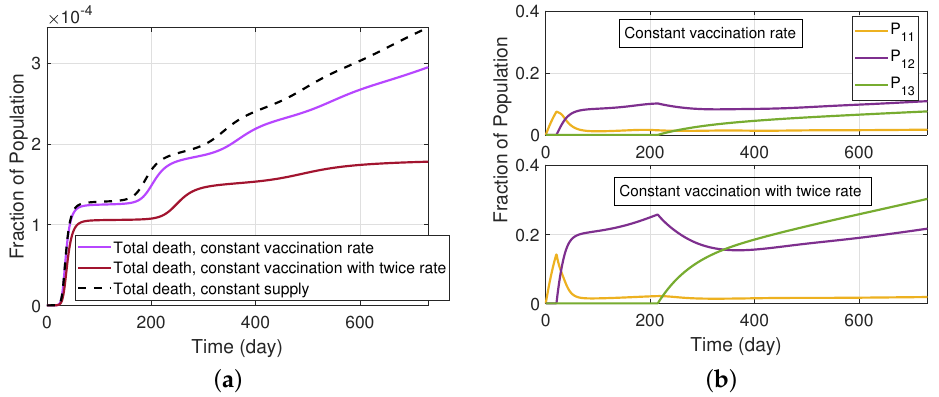
Figure 13. ( a ) The total deceased fractional population in the SIRS model with a three-dose vaccine (model depicted in Figure 10). We compare the assumption that there is sufficient vaccination supply with the Pfizer vaccine to maintain a constant rate of vaccination for those receiving first, second, and third doses in comparison to maintaining a constant total vaccine supply across all groups. ( b ) Fraction of individuals protected by one, two, and three doses of a vaccine with constant vaccination rates.